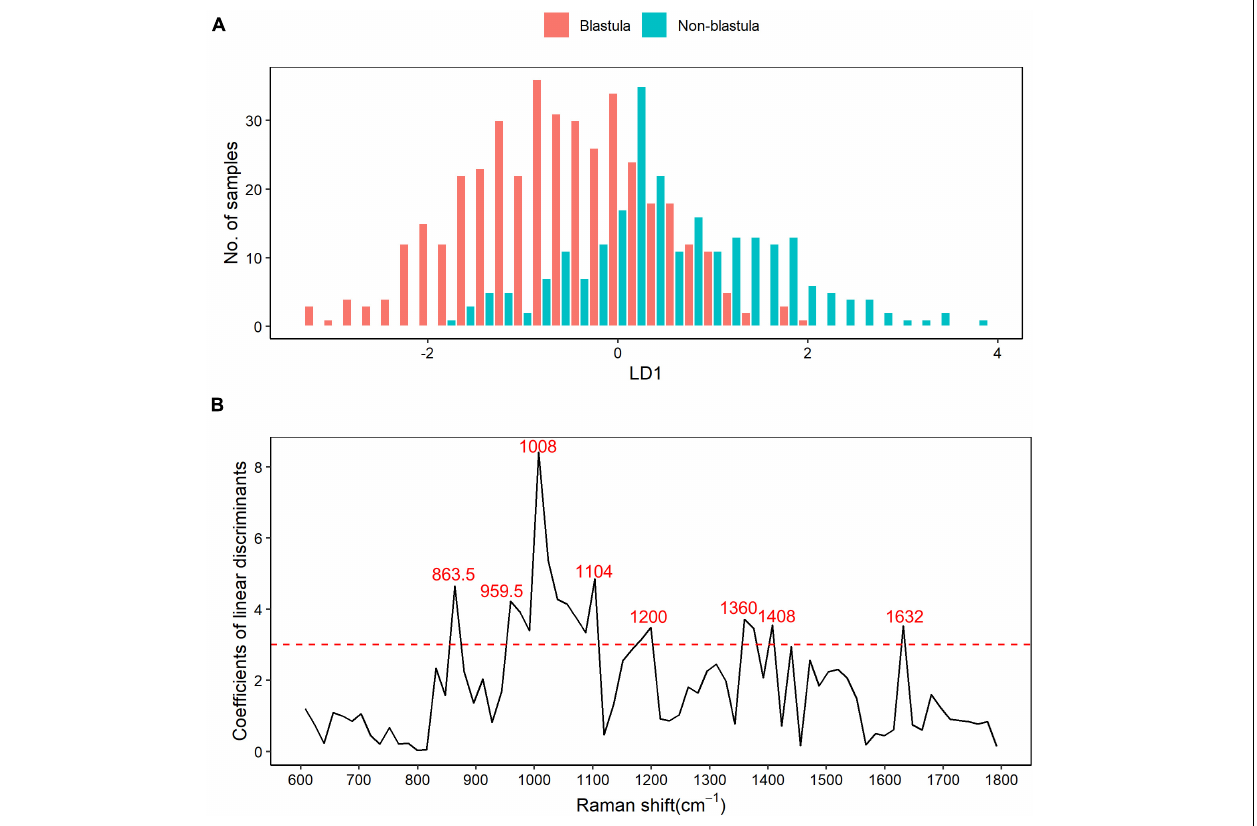
FIGURE 2 | Raman shift based on the linear discriminant analysis (LDA). (A) Result of linear discriminant analysis. LDA for two categories, blastula or non-blastula, results in one linear discriminant factor (LD1). The number of samples across each LD1 in both groups are plotted in the figure, with the blastula group depicted by red bars and the non-blastula group depicted by blue bars. It shows that the blastula and non-blastula samples had a lot of overlaps within the range from –2 to 2 of LD1, while no overlap is observed outside that range. (B) Raman shifts screened by LDA. The coefficients of linear discriminants are plotted against Raman shifts. Raman shifts with a correlation coefficient greater than 3 were selected as bands with a large contribution to the difference between groups of samples based on rule of thumb. With this criterion, eight different Raman shifts are chosen as the main different components between the two